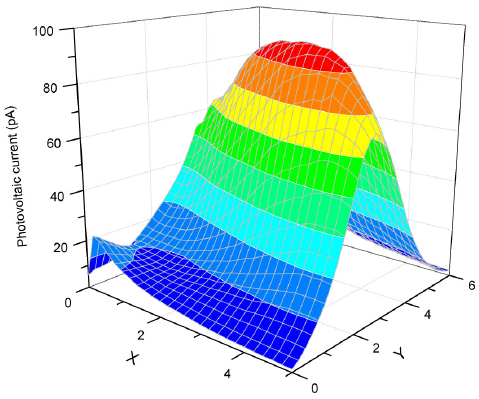
Figure 11. Photovoltaic current generated by a 160 mW/cm 2 of LASER illumination in 750